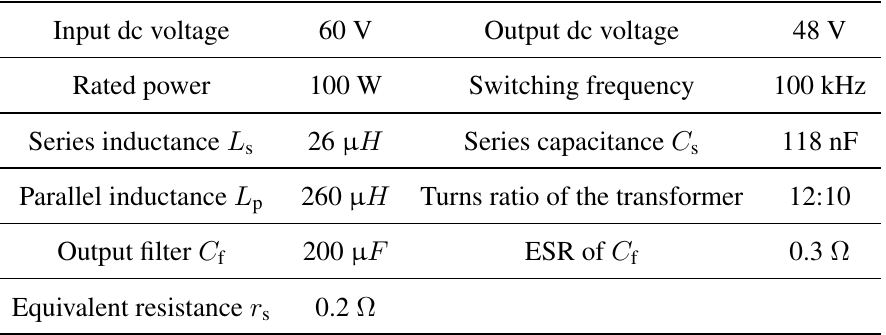
Table 1. Converter specifications for illustration. ESR, equivalent series